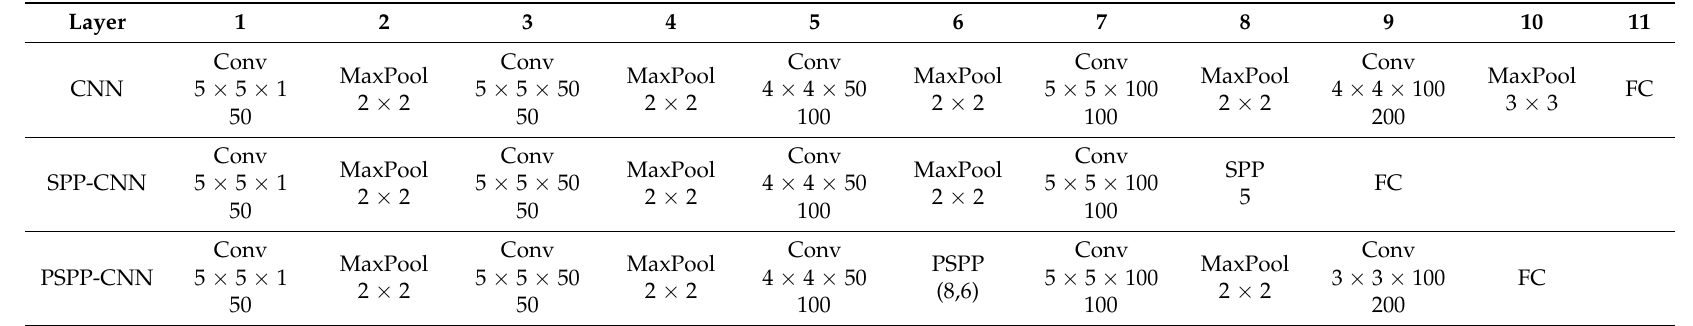
Table 4. Structure of three Convolutional neural